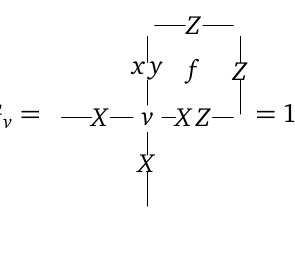
is defined as Z e